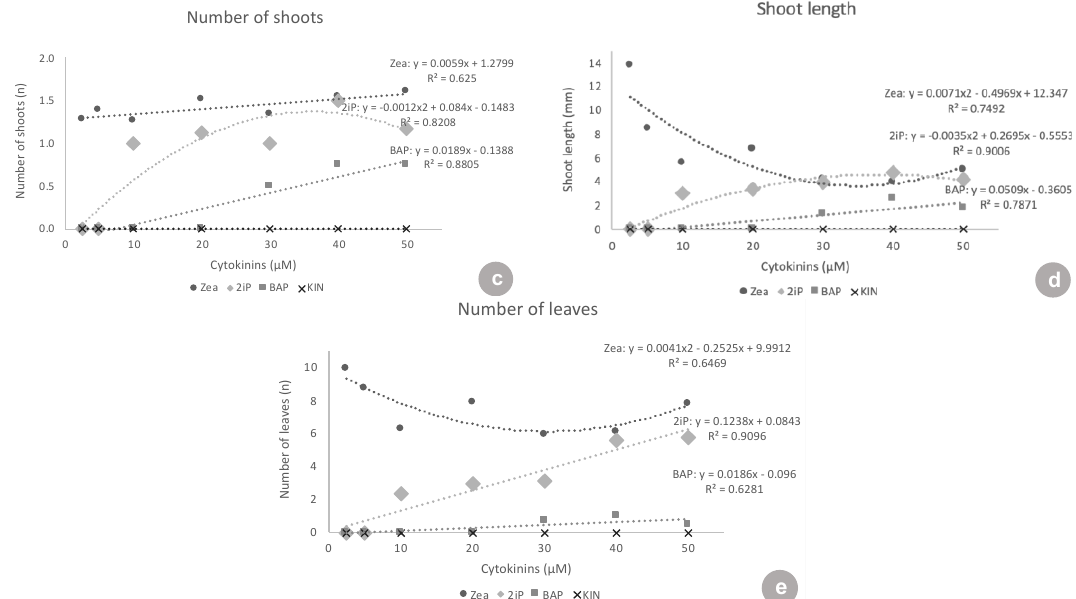
Figure 2. Regression analysis related to different cytokinin (ZEA, 2iP, BAP, and KIN) concentrations (2.5, 5, 10, 20, 30, 40, and 50 µM) on in vitro establishment of 'Delite' rabbiteye blueberry. ( a ) Survival (%); ( b ) shoot formation (%); ( c ) number of shoots (nº); ( d ) shoot length (mm); ( e ) number of leaves (nº). Abbreviations: BAP, 6-benzylaminopurine; KIN, kinetin; ZEA, zeatin; 2iP, 6-( γ - γ